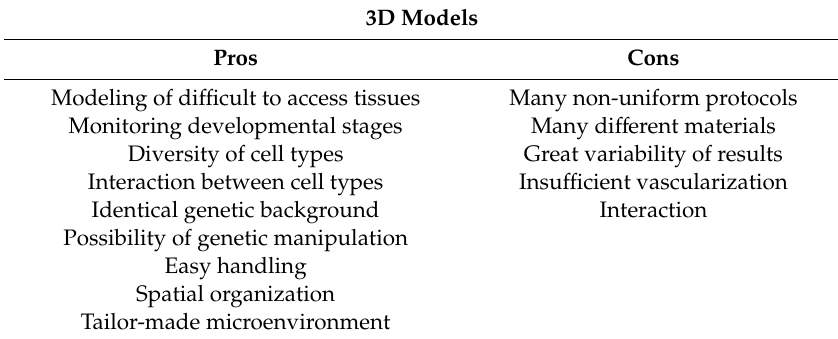
Table 6. Summary of the most common advantages and disadvantages of 3D cultivation